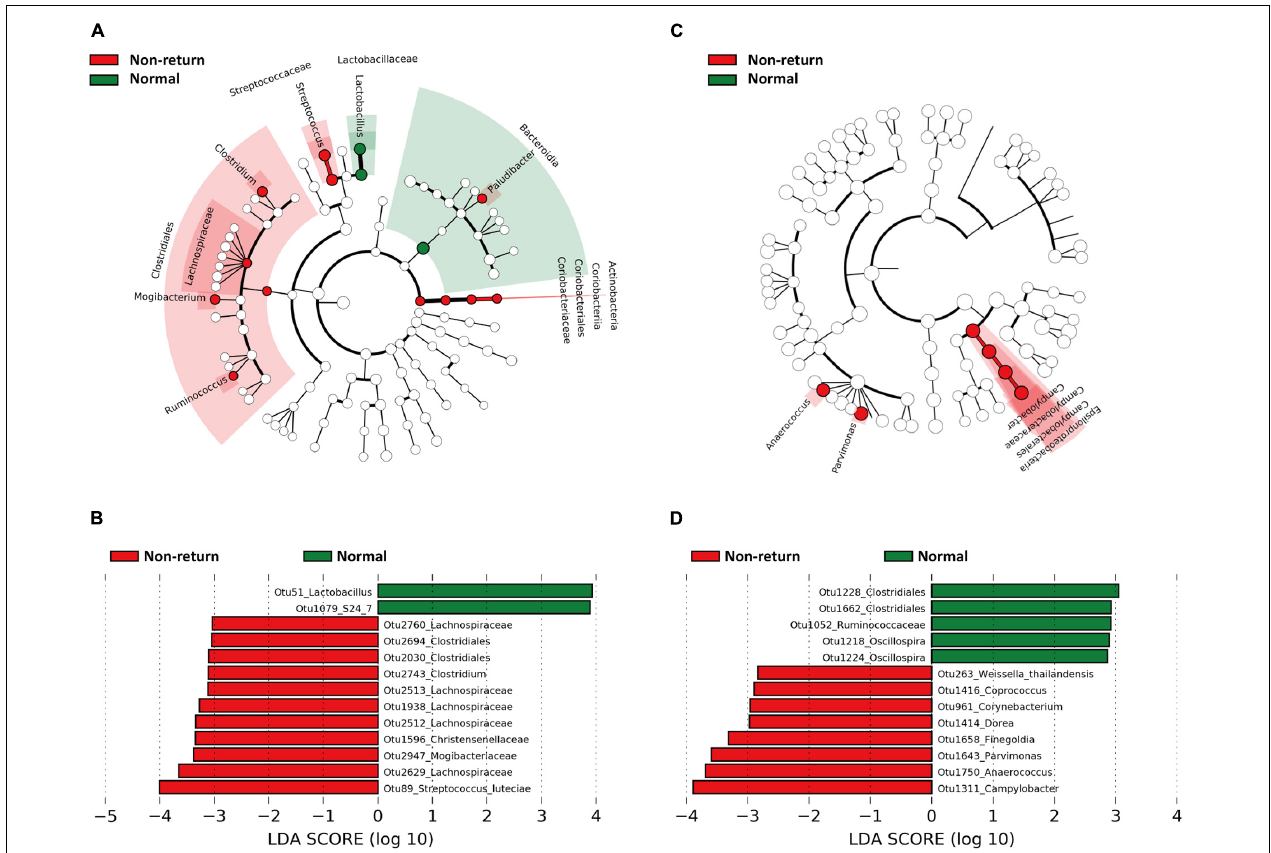
FIGURE 2 | Bacterial taxa and OTUs showing different abundances between normal return and non-return sows identified by Linear discriminant analysis effect size (LEfSe) analysis. The cycles from inside to outside represent kingdom, phylum, class, order, family, and genus. (A) Bacterial taxa showing different abundances between normal return and non-return sows in fecal samples (| LDA| score > 2, p < 0.05). (B) Differential OTUs in fecal samples (| LDA| score > 3, p < 0.05). (C) Differential bacterial taxa in vaginal samples (| LDA| score > 2, p < 0.05). (D) Differential OTUs in vaginal samples (| LDA| score > 2, p <